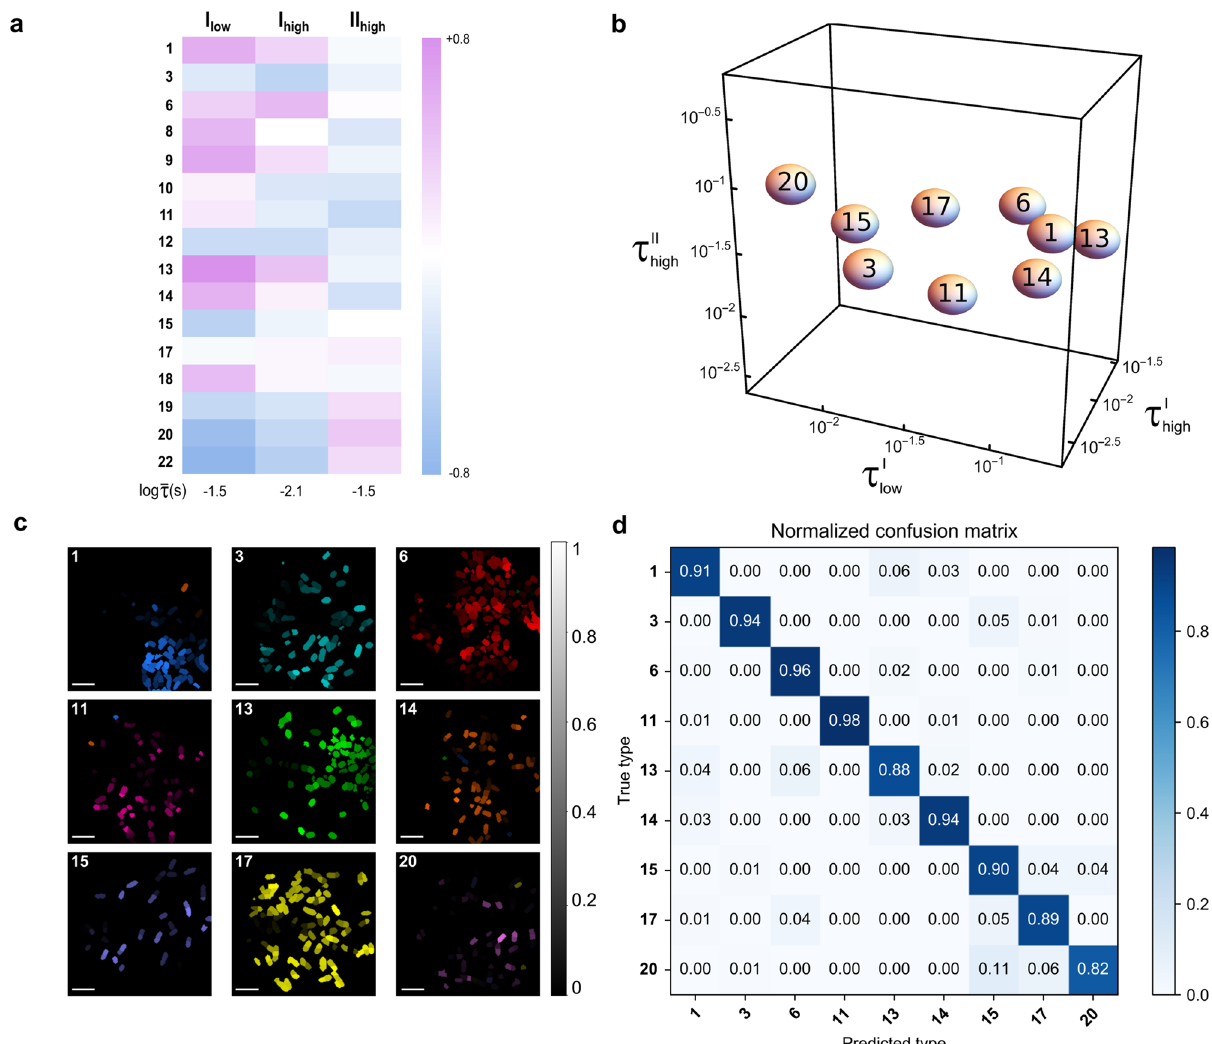
Fig. 4 LIGHTNING in action in fi xed RSFP-expressing Escherichia coli bacteria. a Heatmap displaying the deviations from the mean value τ over the RSFPs of the characteristic times measured over the [1 ms – 1 s] time window for each illumination for the RSFP-labeled bacteria in decimal logarithmic scale; b LIGHTNING discrimination in RSFP-labeled bacteria in the 3D space of accessible characteristic times. The volume associated with each RSFP is fi xed by the resolution limit; c LIGHTNING images of 9 types of RSFP-labeled bacteria. The maximum probability that a bacterium is identical to a tabulated RSFP- labeled bacterium sets the lightness (linear grey scale between 0 and 1). A false color is assigned to each predicted type and the true type is indicated in the top left of the image of each sample. Scaling bar = 5 μ m; d Confusion matrix associated with the 9 discriminated types of RSFP-labeled bacteria (proportion of true and false positives with linear scale between 0 and 1). I low ( I 1 = 2), II low ( I 1 = 2, I 2 = 0.2), I high ( I 1 = 50), and II high ( I 1 = 50 and I 2 = 20) with I 1 and I 2 in ein m − 2 s − 1 . T = 298